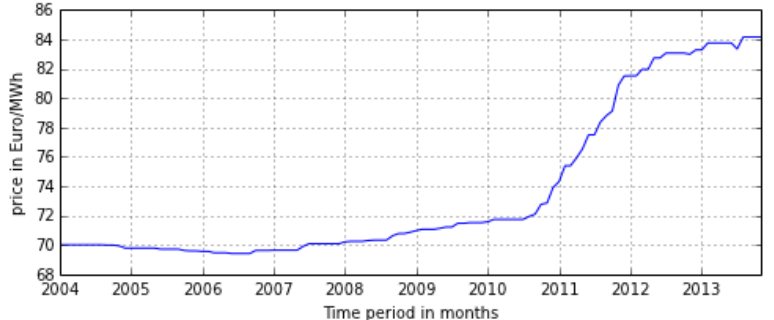
Figure 3. Generation ‐ weighted average wind power price for the period from January 2004 to November 2013.